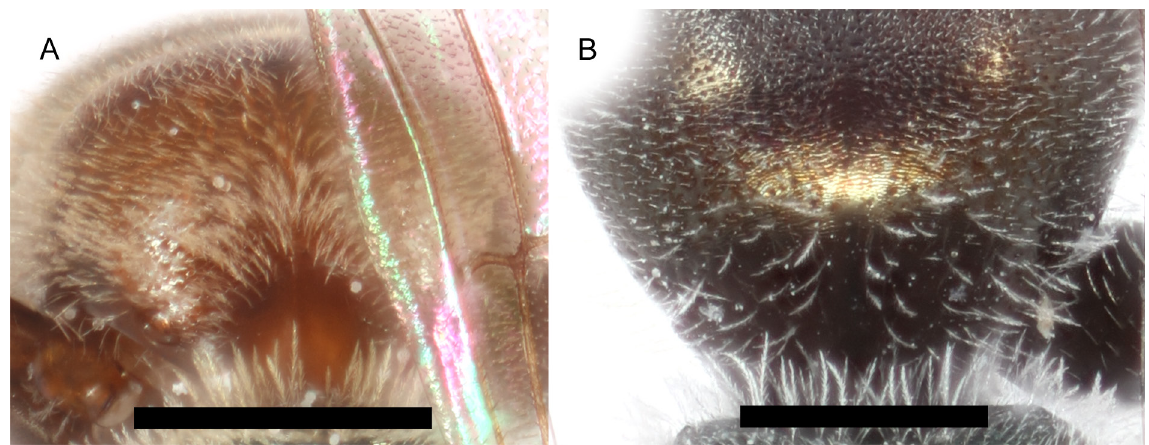
Fig. 111. T1 anterior surface. A . Lasioglossum ( D. ) vierecki (Crawford, 1904), ♂, with dense appressed hair. B . L. ( D. ) droegei Gibbs, 2009, ♂, without appressed hair. Scale bars: 0.5 mm.